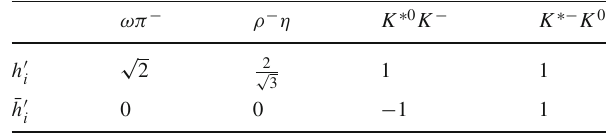
Table 2 Same as Table 1 but for I = 1, G = + 1